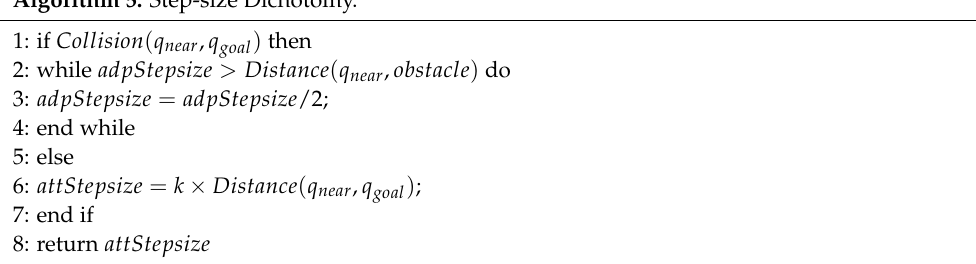
Algorithm 5. Step-size